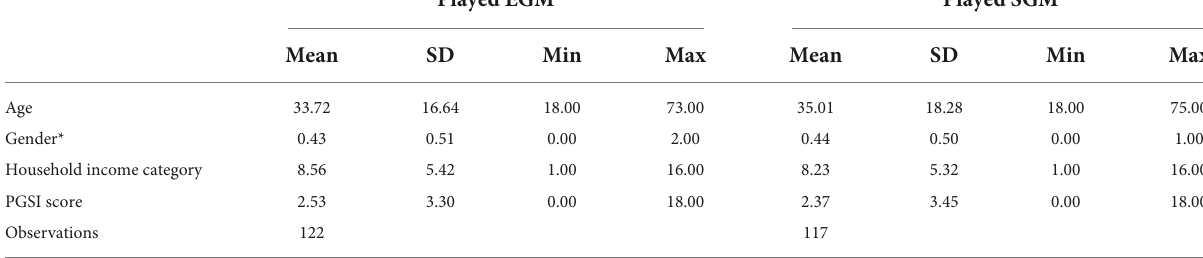
TABLE 1 Summary statistics by assignment